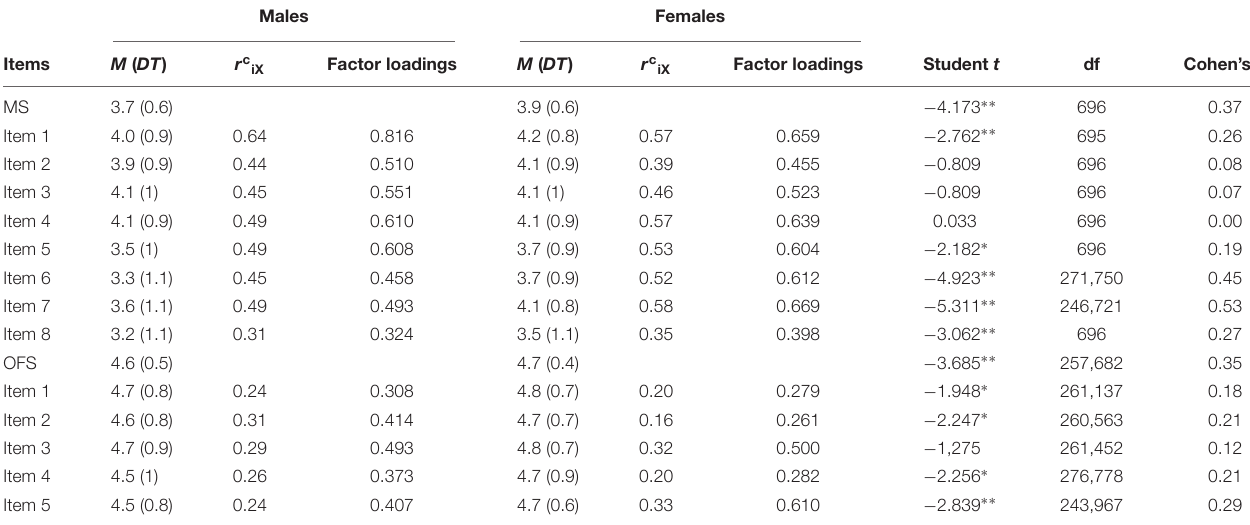
TABLE 2 | Descriptive statistics and factor loadings (CFA two-factor merge model) and mean scores comparison of MS and OFS for males ( n = 176) and females ( n = 524). Males